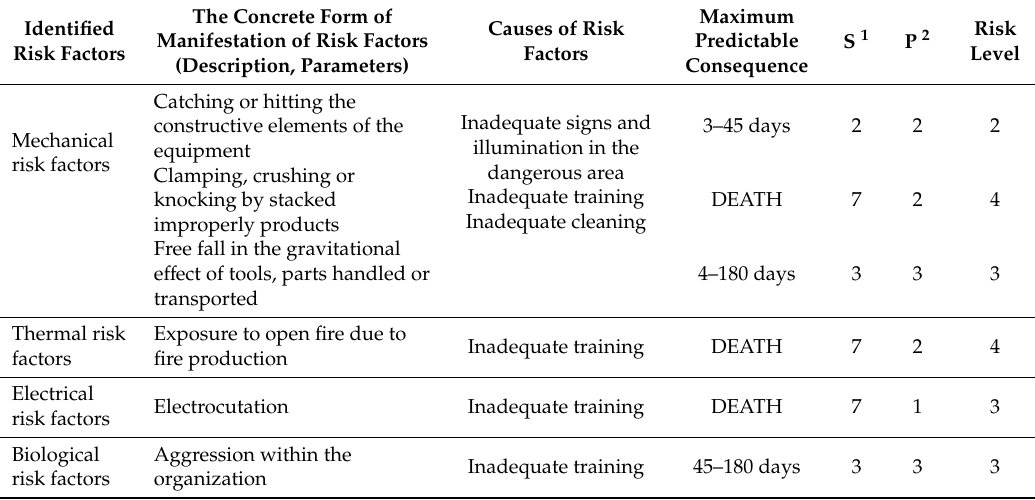
Table 1. Analysis and evaluation of the risks of injury and occupational disease related to the production equipment factors.